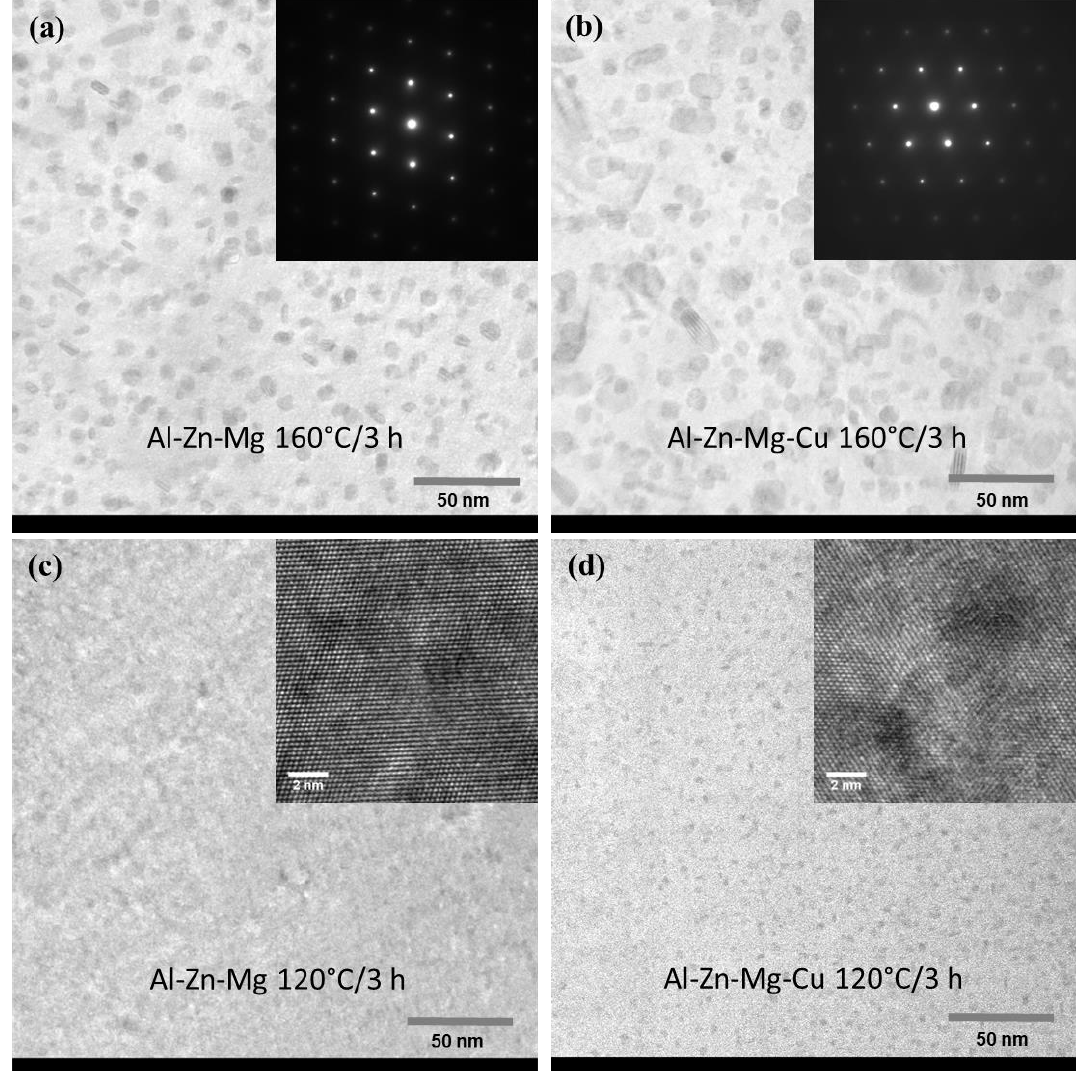
Figure 5. TEM images of ( a ) Al-Zn-Mg alloy after 160 ◦ C / 3 h, with inset of SADP of Al < 011 > , ( b ) Al-Zn-Mg-Cu alloy after 160 ◦ C / 3 h with inset of SADP of Al < 011 > , ( c ) Al-Zn-Mg alloy after 120 ◦ C / 3 h, with inset of HRTEM image showing coherent interface between precipitates (dark globular features) and Al matrix, ( d ) Al-Zn-Mg-Cu alloy after 120 ◦ C / 3 h, with HRTEM image as an inset, showing coherent interface between precipitates (dark globular features) and Al